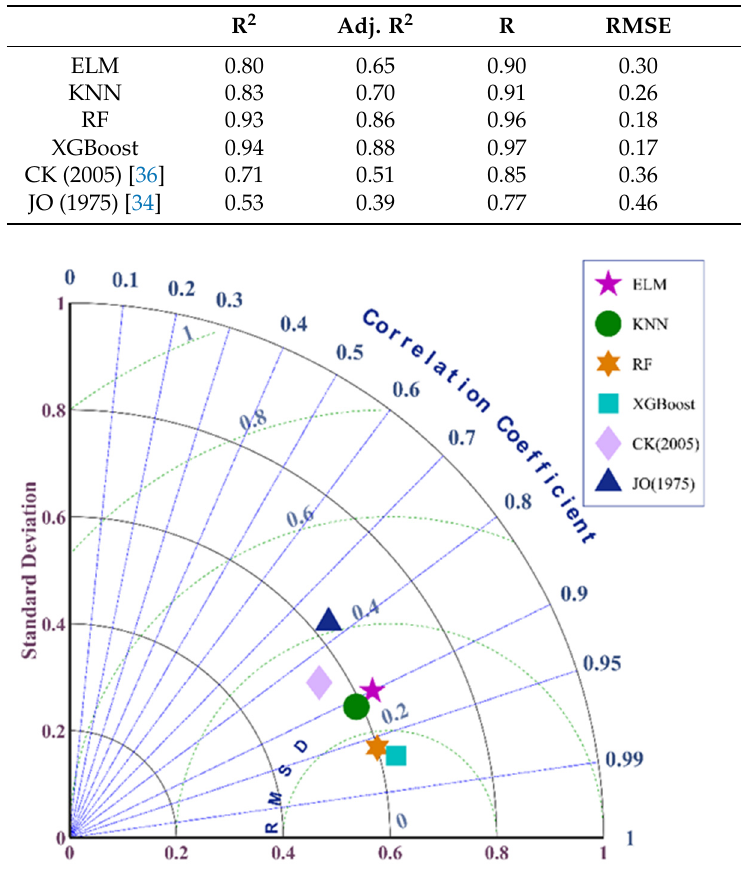
Figure 4. Taylor diagram of test results for six models [34,36].